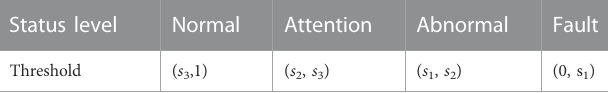
TABLE 2 Relationship between status level and interval